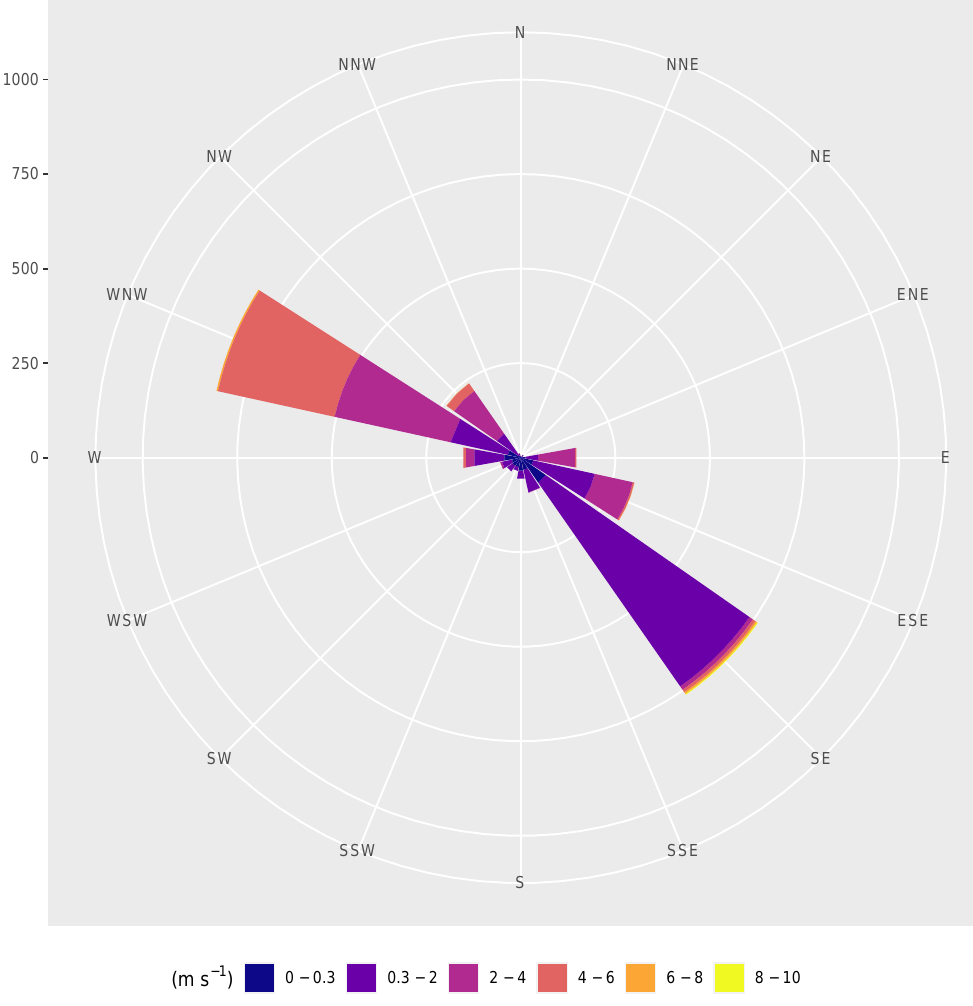
Figure 4. Wind rose of hourly wind speeds during the VWD at the Na